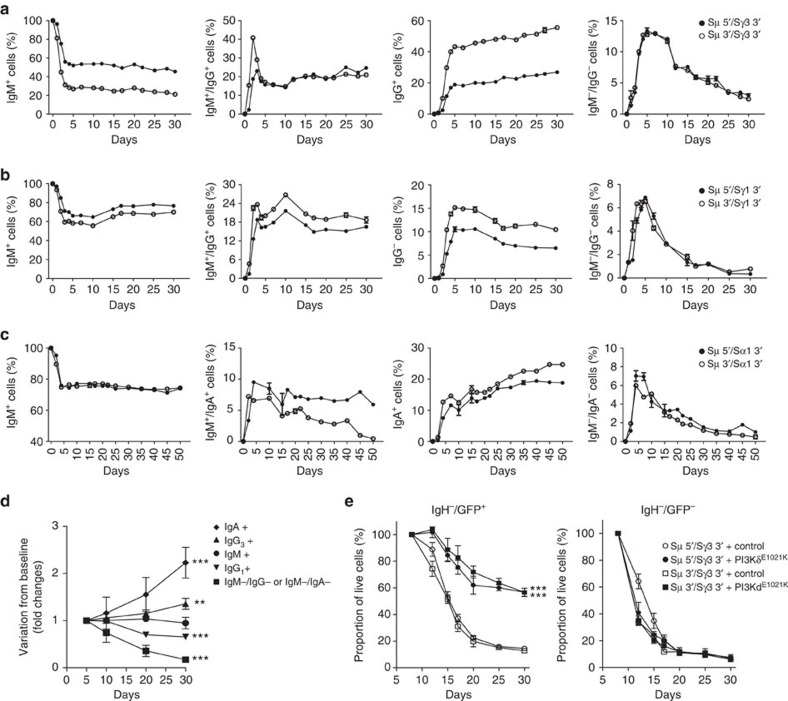
Biological effects of IgH subclass switch in human lymphoma cell growth.(a–c) To understand the growth of B cells after switch of the IgH subclass, JEKO-1 cells were co-transduced with two lentiviruses expressing Cas9 nuclease and gRNAs targeting Sμ, Sγ3 3′ (a), Sγ1 3′ (b) and Sα1 3′ (c) flanking regions. Cells were co-stained with antibodies against IgM and IgG or IgA and analysed by flow cytometry over time. (d) Statistical analysis of relative growth rates from lymphoma cells from Fig. 4a–c. Data are from at least four experiments in each condition. P values are calculated for each IgH subclass compared with native IgM+ cells. Data are expressed as mean ±s.d. for four independent experiments. Statistical analysis determined using two-way ANOVA (**P<0.01; ***P<0.001). (e) JEKO-1 cells were transduced with lentiviruses expressing Cas9 nuclease and gRNAs targeting Sμ and Sγ 3 regions. After 5 days, cells were transduced with retroviral vector expressing PI3KδE1021K or control vector. Cells were co-stained with antibodies against IgM and IgG to allow the gating on the IgH-negative population (IgH−=IgM−/IgG−) and percentages of GFP+ cells were analysed over time by flow cytometry. As additional control IgH- cells not transduced with the retrovirus (GFP−) were analysed. Data are from two independent experiments each repeated in duplicates and are expressed as mean±s.d. Statistical analysis determined using two-way ANOVA (***P<0.001).